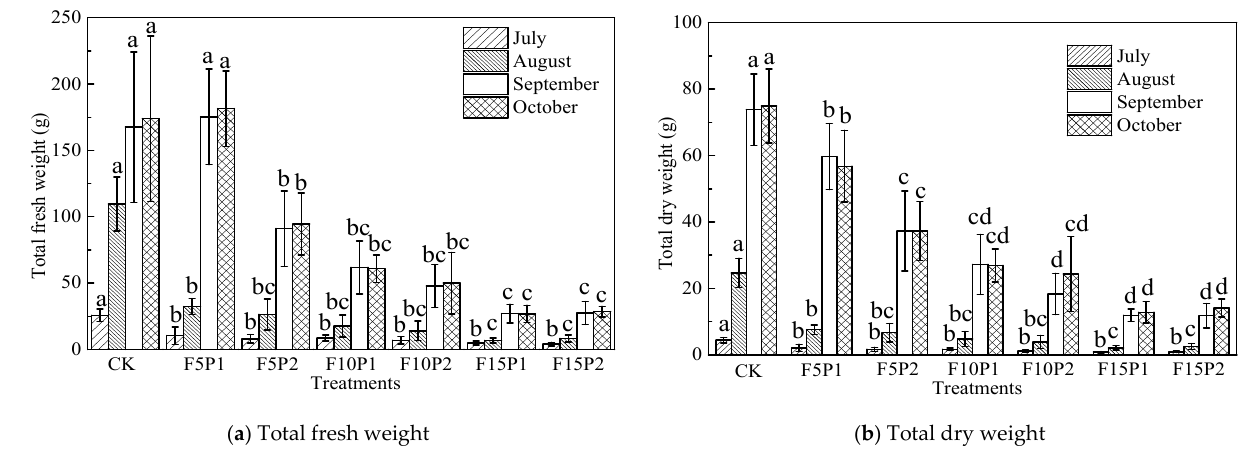
Figure 6. Effects of CSL on total fresh weight ( a ) and total dry weight ( b ) of Artemisia ordosica . Note: Letters indicate significant differences of biomass in CK and CSL in the same month.